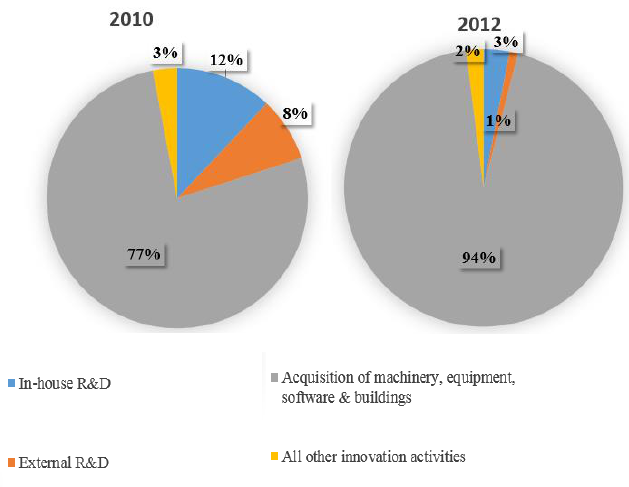
Fig. 3. Expenditures on technological innovation by type of expenditure (as % of total expenditure on innovation activities) (the author’s chart based on CSP,